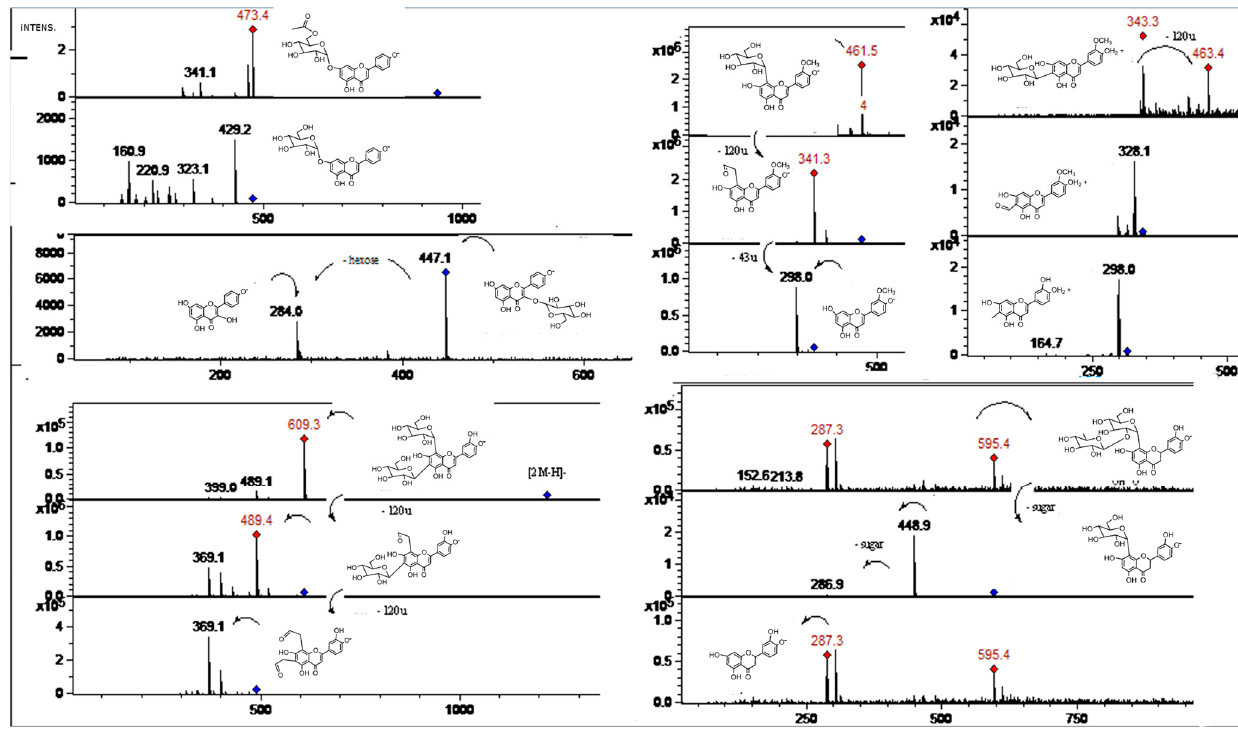
Figure 7. MS spectra of peaks 13 , 17 , 25 , 31 , and 33 . (Refer to Table